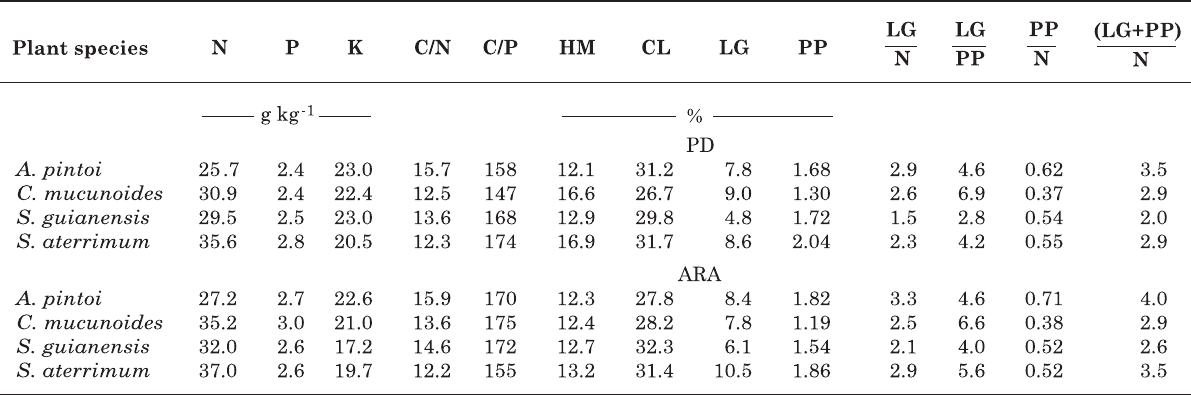
Table 1. Chemical and biochemical properties of leguminous plants from farms in Pedra Dourada (PD) and Araponga